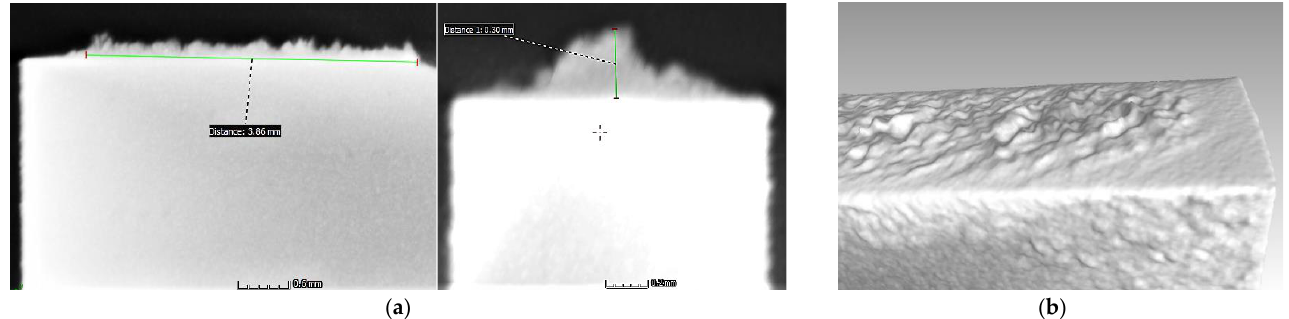
Figure 10. Fracture obtained in dumpling area after mechanical testing (CoCr part): ( a ) CT section; ( b ) virtual reconstruction.